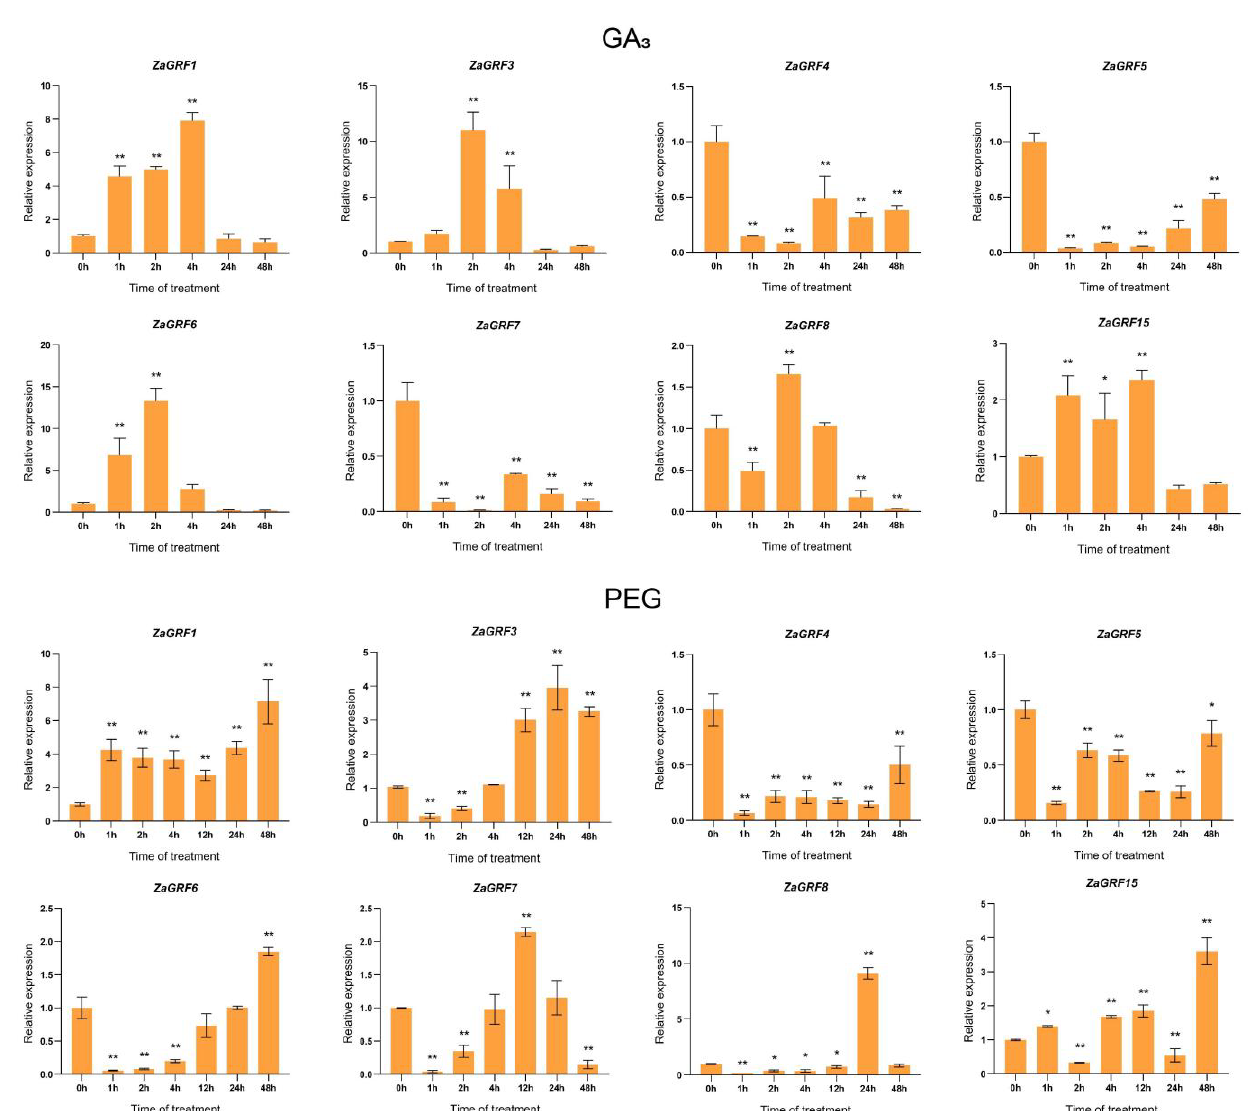
Figure 8. Expression of ZaGRF genes in response to NAA, GA 3 , and PEG treatment. The error bars represent the standard error of the means of three independent replicates of qRT-PCR analysis. p values were determined according to one-factor ANOVA test (* p < 0.05, ** p < 0.01).